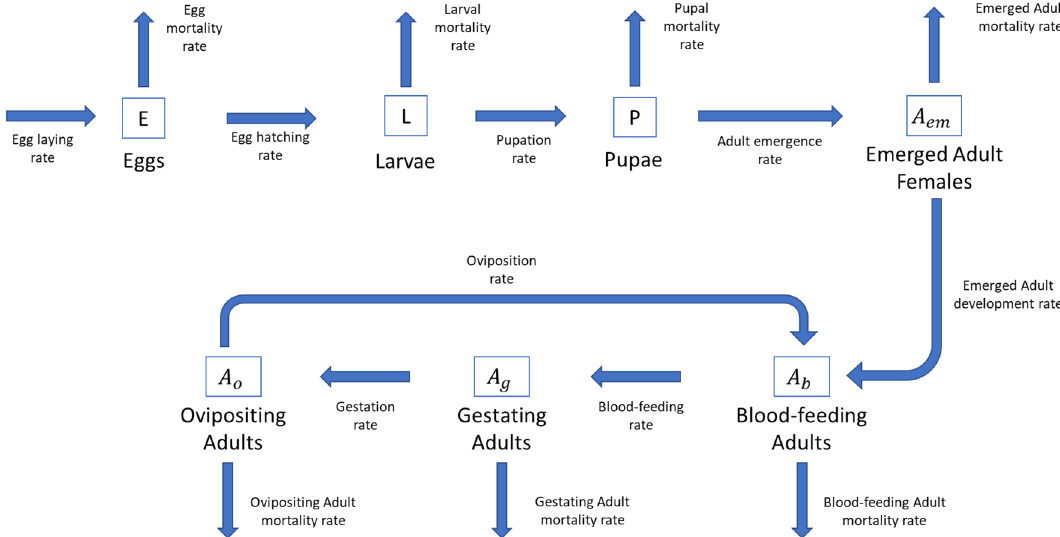
Figure 7. Population dynamics model.